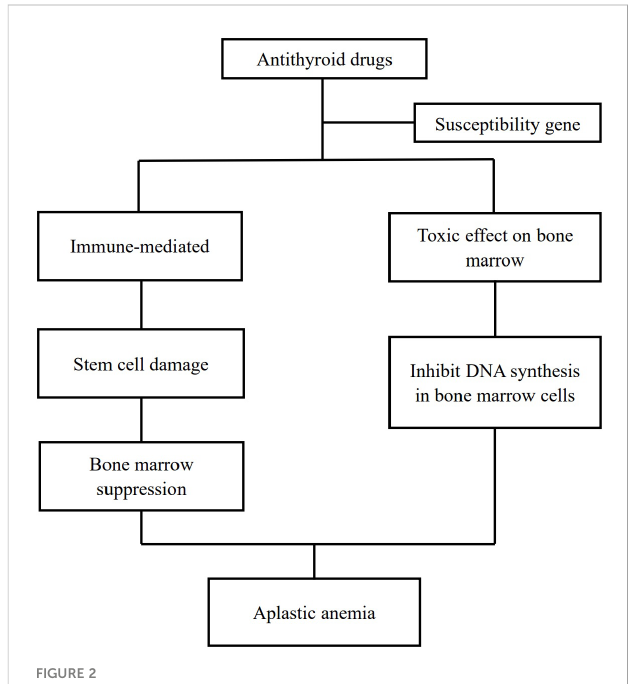
FIGURE 2 Mechanism of antithyroid drugs induced aplastic